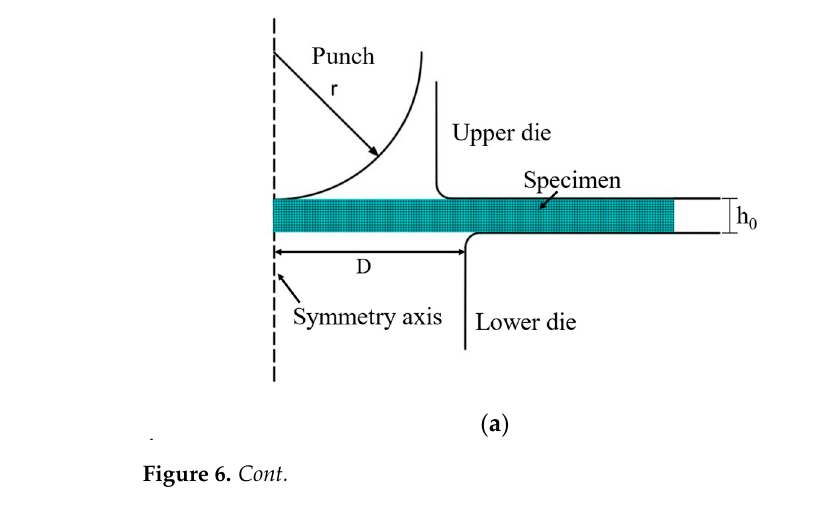
( c ) Figure 6. Schematic diagram of FE model of SPT. ( a ) 2D model; ( b ) 3D model with square specimen; ( c ) 3D model with round specimen.